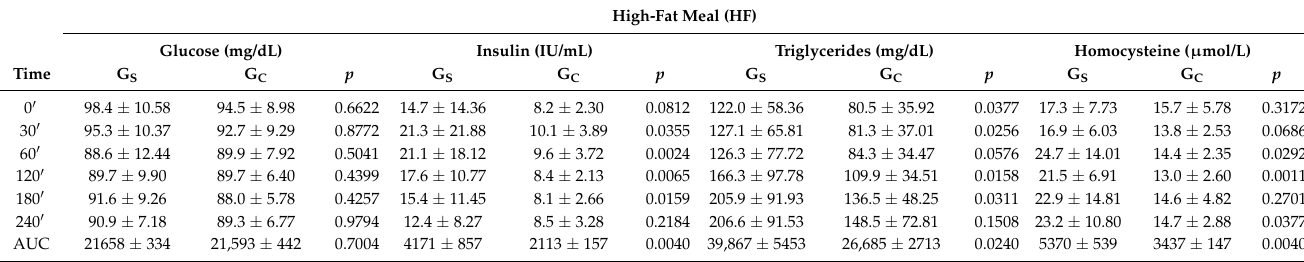
Table 3. Serum concentrations of the biochemical parameters in overweight/obese (G S ) men and normal body weight (G C ) men on fasting (time 0 (cid:48) ) and after (time 30 (cid:48) –240 (cid:48) ) high-fat (HF) and high-carbohydrate (HC) meal. ( AUC (area under the curve)). High-Fat Meal (HF) Insulin (IU/mL) Triglycerides (mg/dL) Homocysteine ( µ mol/L)